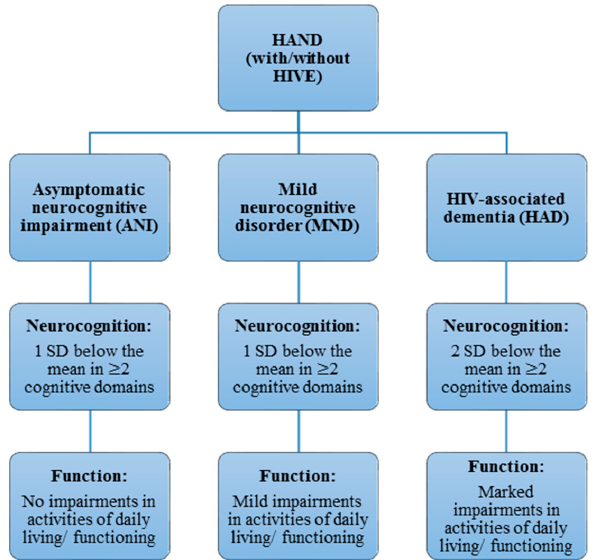
Figure 1. Categories and types of human immunodeficiency virus (HIV)-associated neurocognitive disorder (HAND), according to the Frascati criteria. When diagnosing patients with HAND, it is